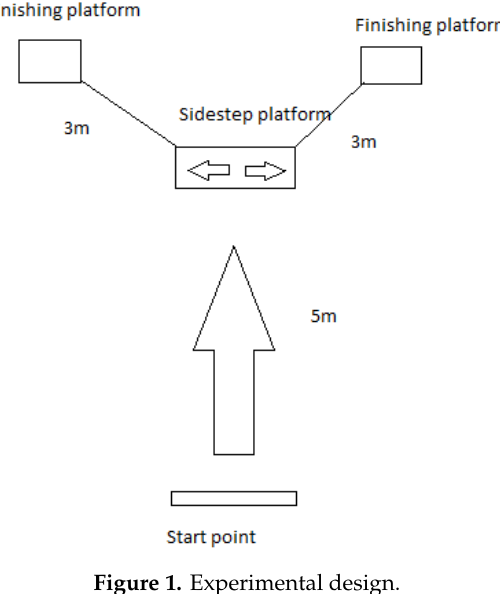
Figure 1. Experimental design.